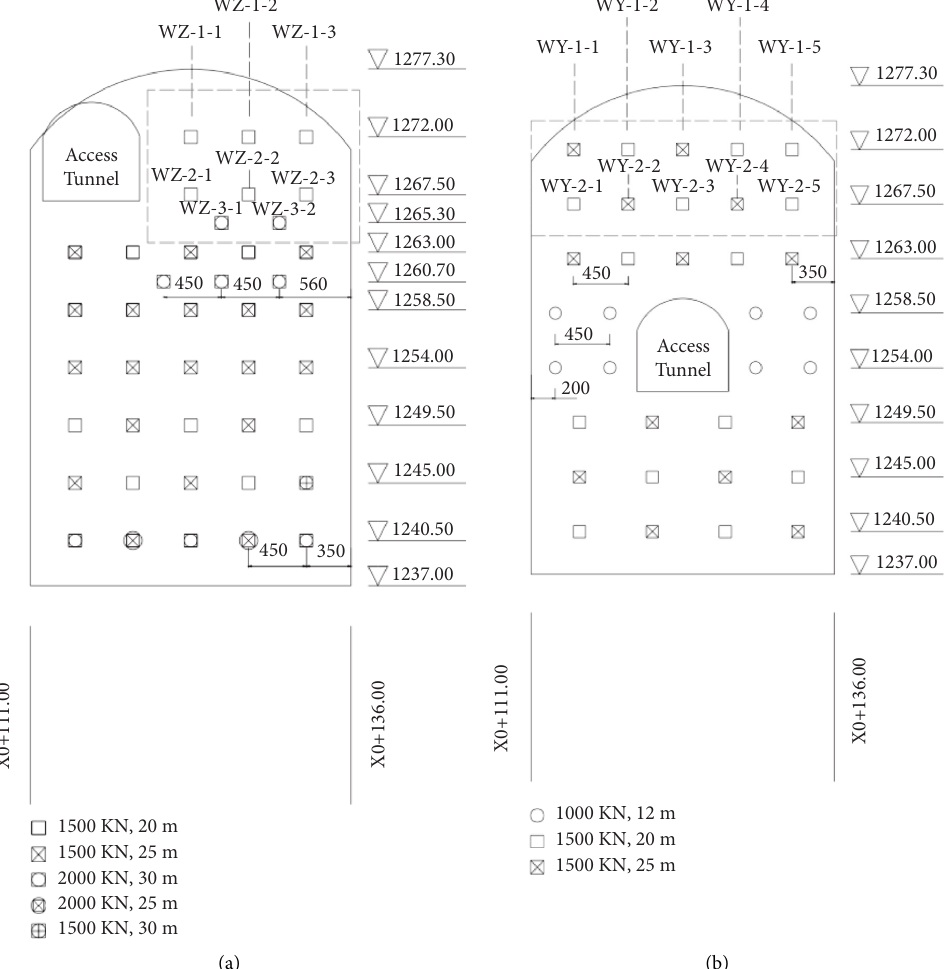
Figure 11: Distribution and numbers of anchor cables on the left-end wall and the right-end wall of the tailrace surge chamber. (a) Left-end wall. (b) Right-end wall. Table 5: Investigation record of anchor heads on left-end wall of the tailrace surge chamber.